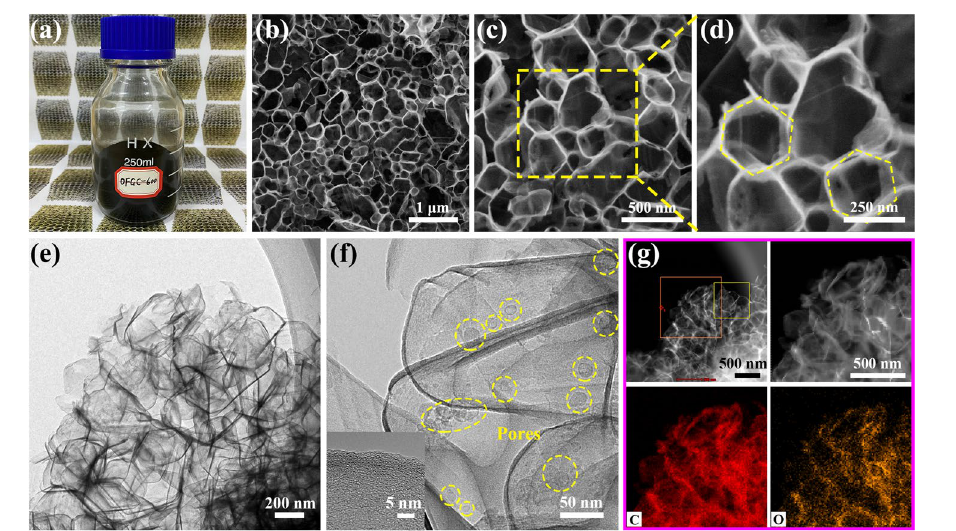
Fig. 1 a Photograph of the final product of OFGC-600. SEM images of OFGC-600 at b the low magnification and c - d the high magnification, e TEM image. f The internal pore structure (circled in yellow) of OFGC-600 and the high-resolution TEM image of OFGC-600 (the lower-left illustration). g EDX elemental mapping of carbon and oxygen